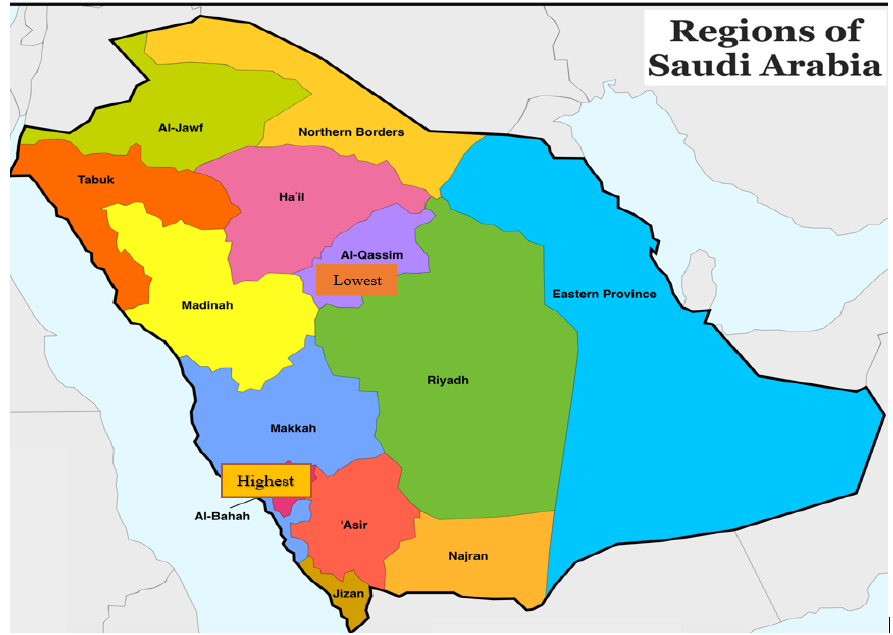
Figure 4. Brain Cancer: CIR by Geographical regions in Saudi Arabia. Source: https://www.orang- esmile.com/travelguide/saudi-arabia/country-maps-provinces.htm.